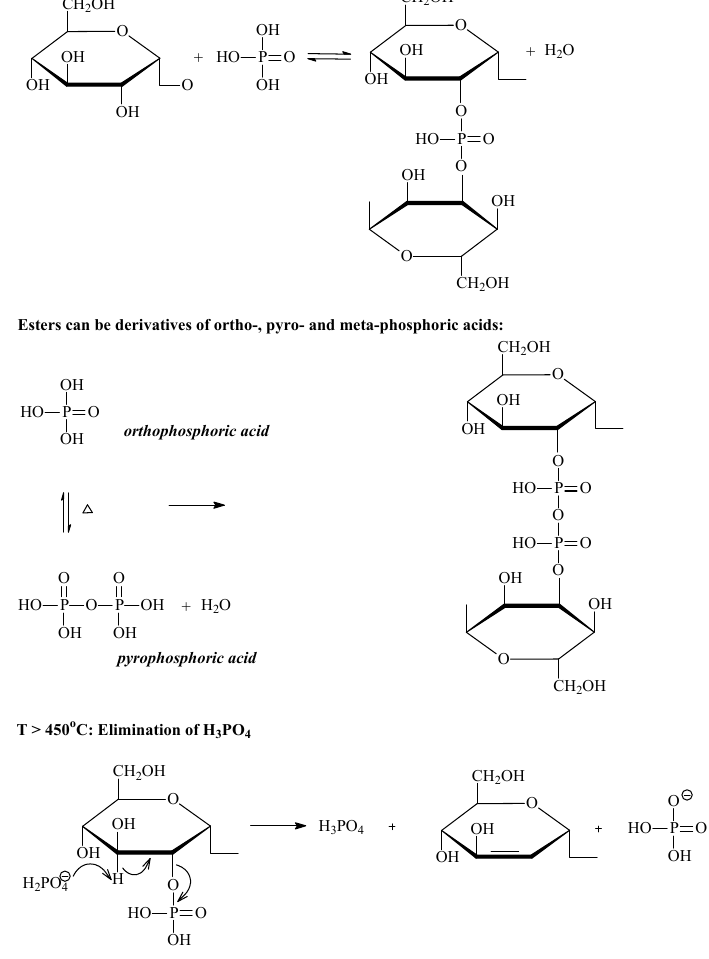
Figure 12. Mechanism of phosphate ester formation by phosphorylation of cellulose. Reproduced from [72] with permission from Elsevier © 1998.